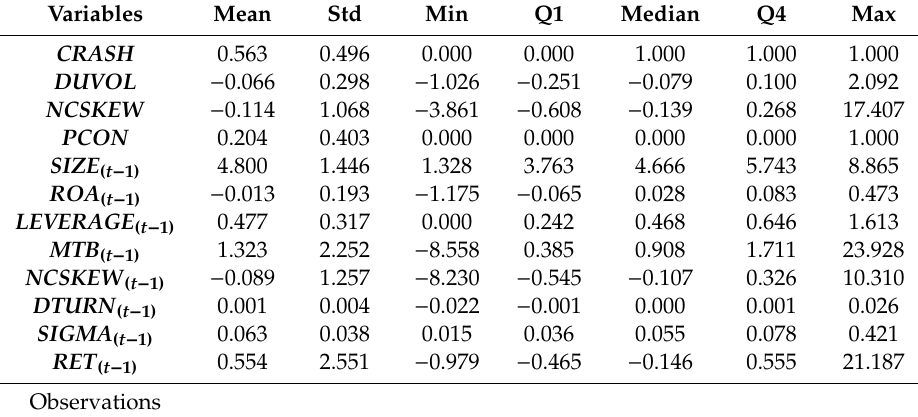
Table 2. Summary statistics (n =